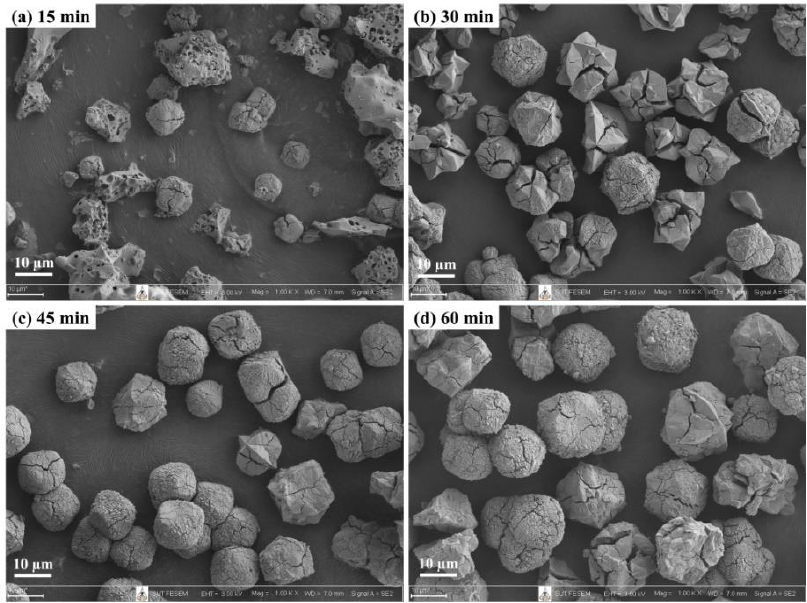
Figure 4. FESEM images of zeolite products from microwave-assisted hydrothermal methods with single crystallization at 150 ◦ C for various times: ( a ) 15, ( b ) 30, ( c ) 45 and ( d ) 60